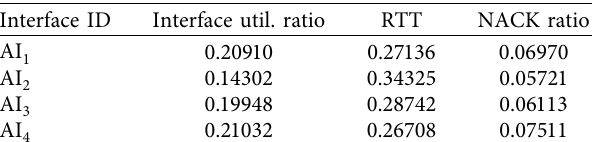
Table 4: Weighted normalized decision matrix for